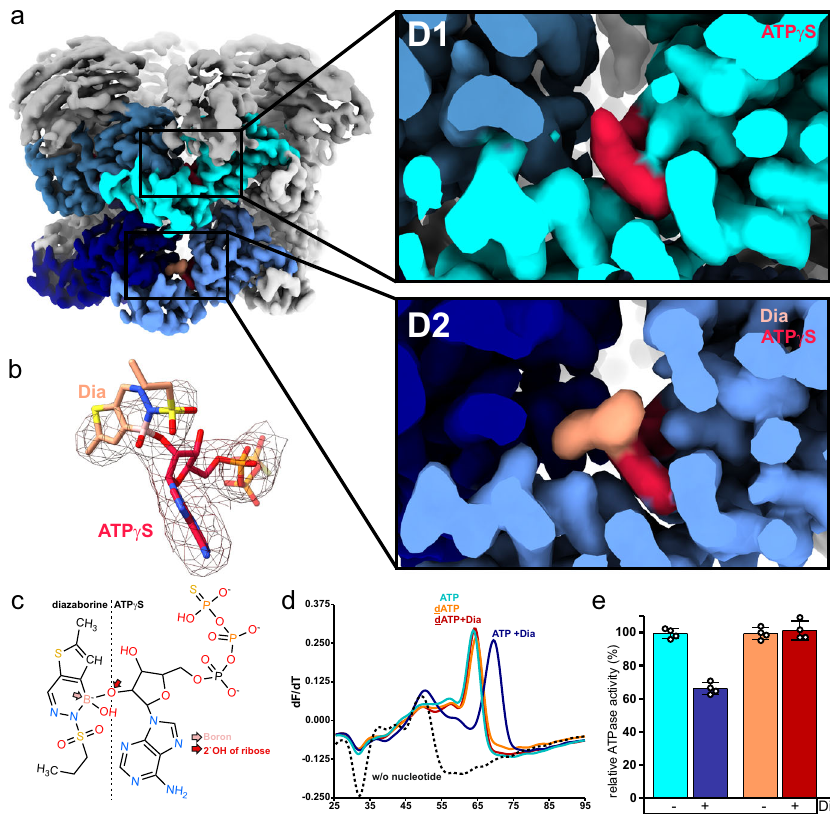
Fig. 2 Diazaborine forms a covalent adduct with the nucleotide in the D2 AAA-domain of Drg1. a All six nucleotide-binding pockets of the D2 AAA- domains of Drg1 contain a continuous density representing a covalent adduct between the bound nucleotide ATP γ S and the inhibitor diazaborine. b The isolated density of the inhibitor-nucleotide adduct in D2. c The covalent bond is formed between the boron atom of diazaborine and the 2 ′ -OH group of the nucleotide ribose moiety. d Diazaborine cannot bind to Drg1 in the presence of 2 ′ -deoxy-ATP (dATP) due to the lacking 2 ′ -OH group demonstrated by DSF measurements. The averaged derivative curves (dF/dT) of the melting curves of four measurements from two biological replicates are shown ( n = 4). e Diazaborine does not affect the ATPase activity of Drg1 when dATP is used as cofactor. The stimulated ATPase activity of Drg1 was measured in the presence of either 1 mM ATP (cyan and blue) or dATP (orange and red). The activity was stimulated by the HIS6-tagged C-terminal fragment (amino acids 147 – 199) of the substrate protein Rlp24 19 . Diazaborine was added to a fi nal concentration of 100 µ g/ml. Means and standard deviations are shown from four individual measurements ( n = 4). The speci fi c activity ( µ mol ATP/h/mg Drg1) was calculated and normalized to the uninhibited activity in the presence of ATP ( = 100%). Source data for 2d and 2e are provided as a Source data fi